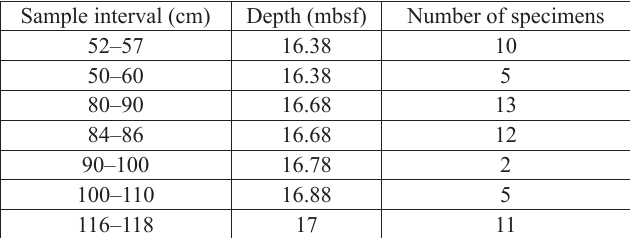
Table 1. Details of specimens obtained from NGHP-01 Site 12 Hole A, Core 3H, Section 2, offshore K-G Basin,